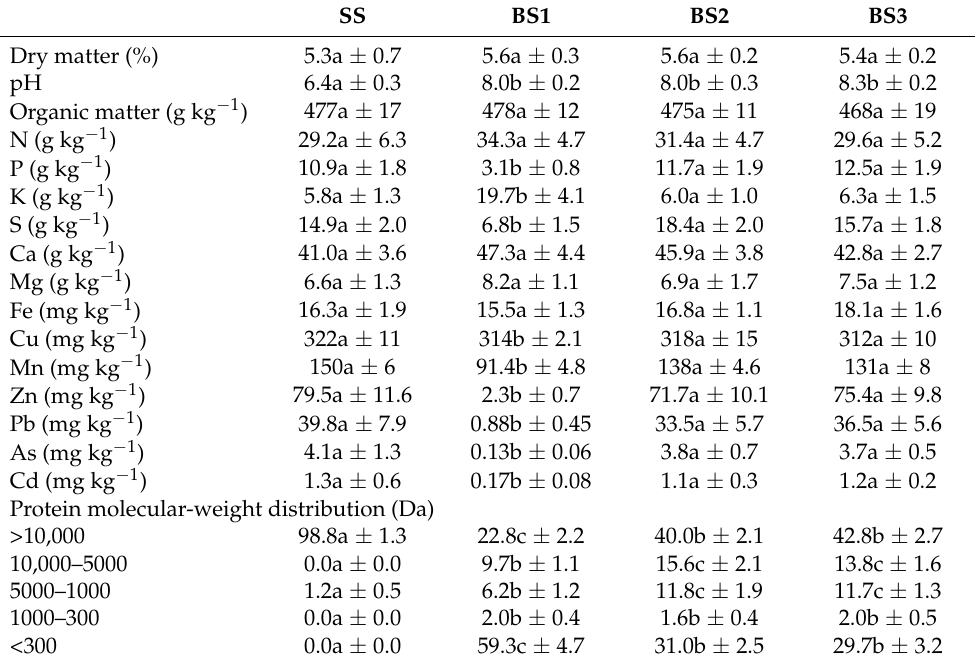
Table 2. Chemical properties (mean ± standard error, n = 3) of sewage sludge and biostimulants obtained by enzymatic hydrolysis and fermentation